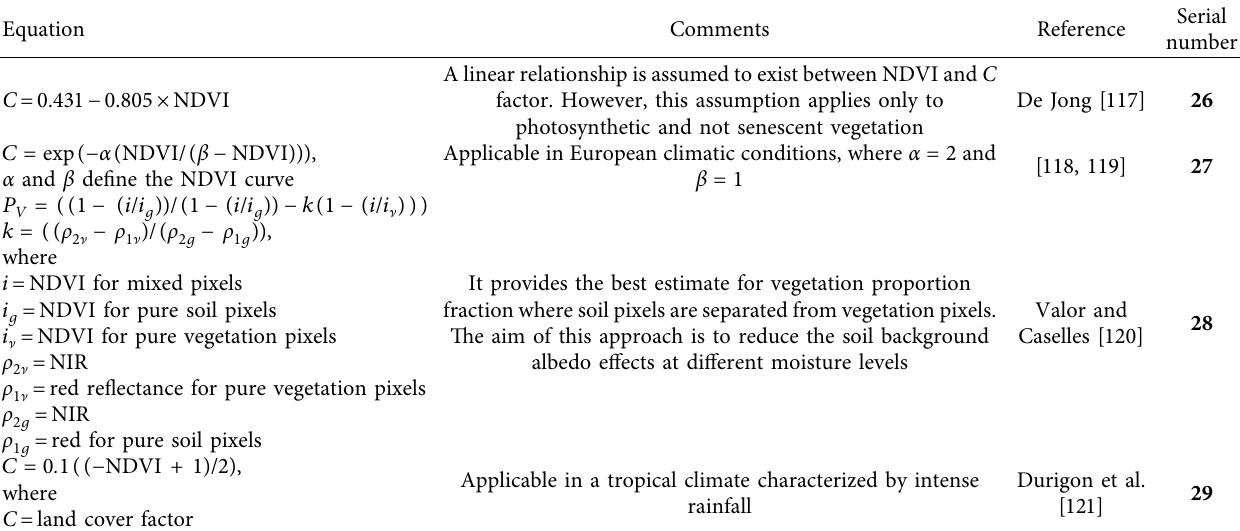
Table 4: C factor algorithms.